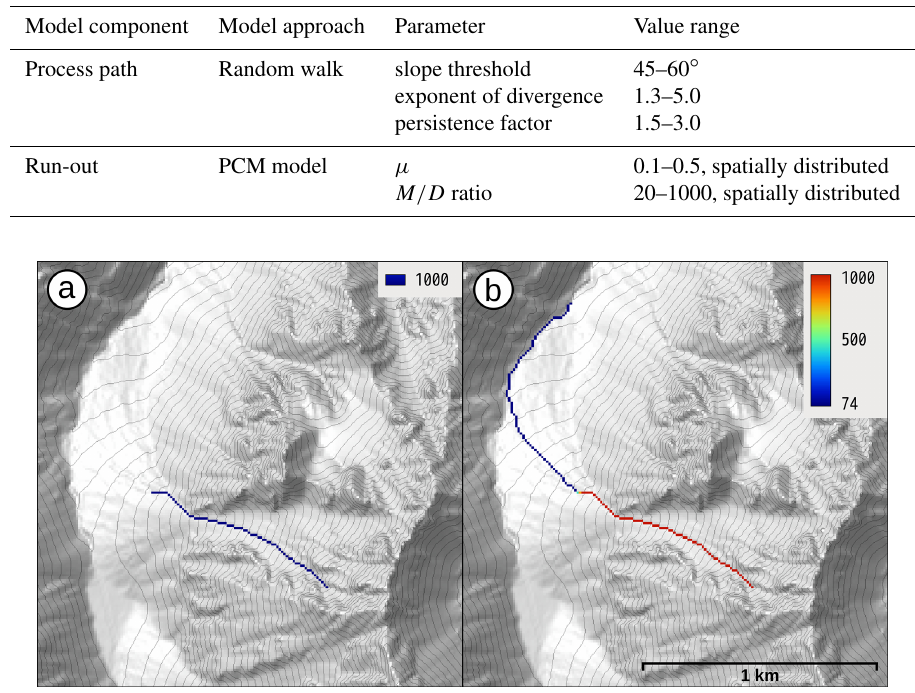
Figure 5. Sink filling: (a) the process stops in a sink; (b) the process overcomes the sink and stops in the next sink because no material is